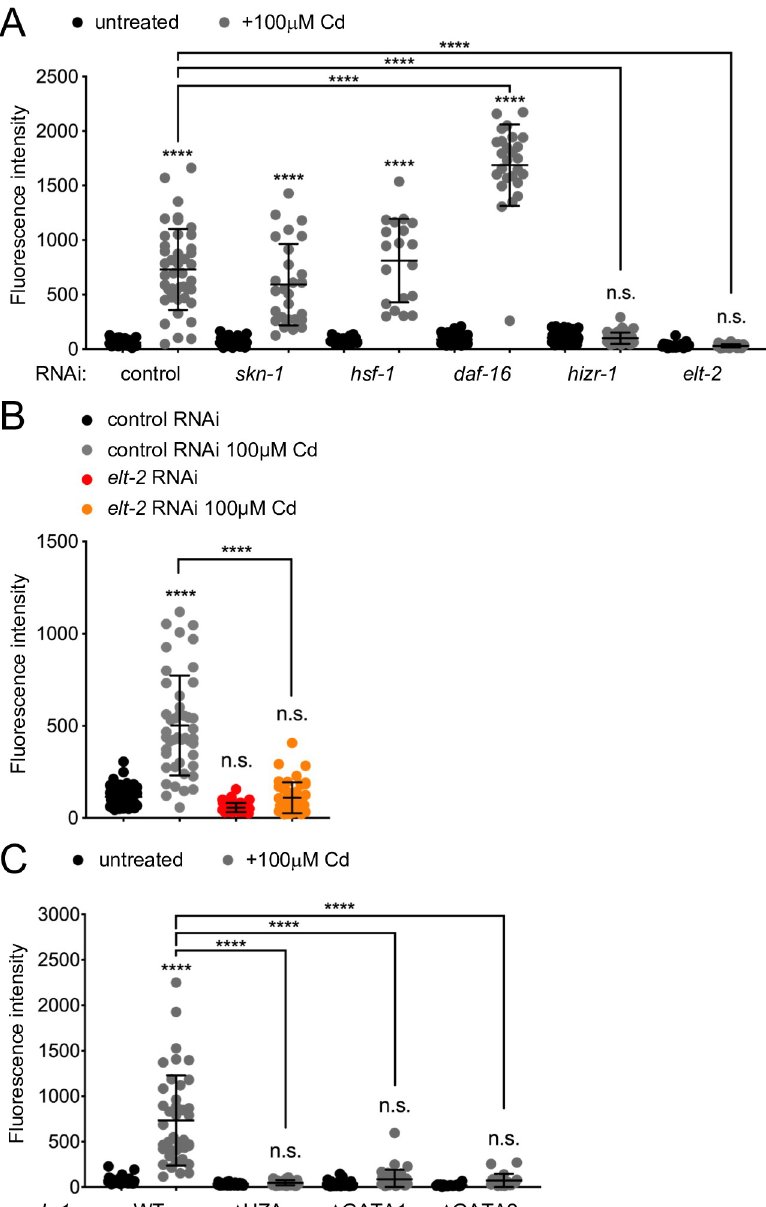
Fig 3. The TFs hizr-1 and elt-2 and their cognate promoter elements are required for the cadmium stress responses. [A] The graph shows the average fluorescence intensity (arbitrary units, A.U.) of worms bearing the cdr- 1p :: gfp transcriptional reporter before and after a 0 μ M or 100 μ M cadmium (Cd) exposure (four hours), and fed either control or transcription factor RNAi, as indicated (control RNAi 0 μ M Cd: n = 51 worms total from 4 independent repeats; control RNAi 100 μ M Cd: n = 43 worms total from 4 independent repeats; skn-1 RNAi 0 μ M Cd: n = 39 worms total from 3 independent repeats; skn-1 RNAi 100 μ M Cd: n = 27 worms total from 3 independent repeats; hsf-1 RNAi 0 μ M Cd: n = 22 worms total from 2 independent repeats; hsf-1 RNAi 100 μ M Cd: n = 19 worms total from 2 independent repeats; daf-16 RNAi 0 μ M Cd: n = 27 worms total from 2 independent repeats; daf-16 RNAi 100 μ M Cd: n = 26 worms total from 2 independent repeats; hizr-1 RNAi 0 μ M Cd: n = 50 worms total from 3 independent repeats; hizr-1 RNAi 100 μ M Cd: n = 40 worms total from 3 independent repeats; elt-2 RNAi 0 μ M Cd: n = 22 worms total from 3 independent repeats; elt-2 RNAi 100 μ M Cd: n = 37 worms total from 3 independent repeats). Error bars: standard deviation. Statistical analysis: ���� p < 0.0001, n.s. = not significant, two-way ANOVA, multiple comparisons, Tukey correction; comparisons are to control(RNAi) 0 μ M Cd unless indicated by lines. [B] The graph shows the average fluorescence intensity (arbitrary units, A.U.) of day-3 old adult worms bearing the cdr-1p :: gfp transcriptional reporter, fed either control or elt-2 RNAi during the first two days of adulthood and then exposed to 0 μ M or 100 μ M